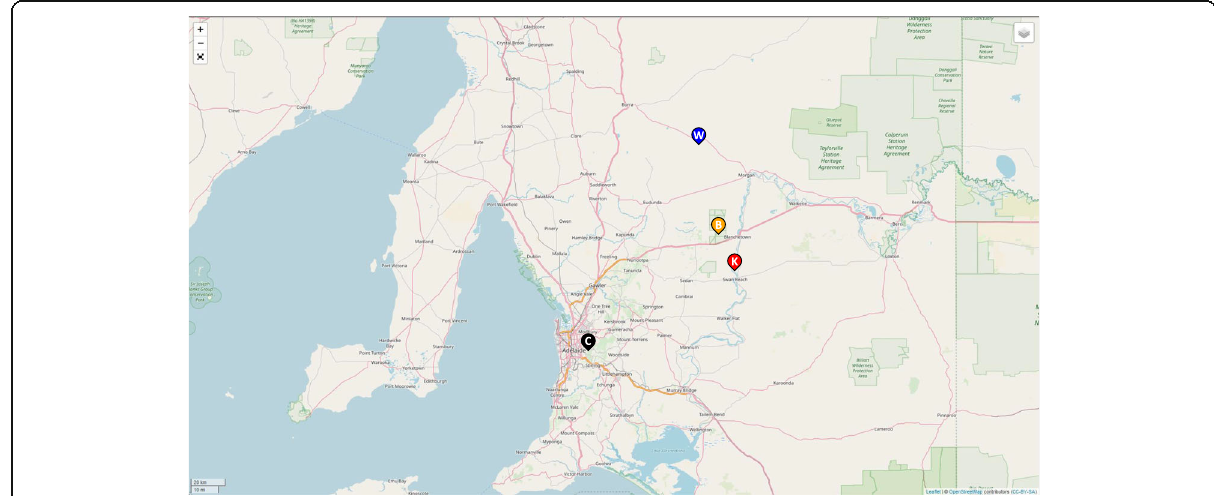
Fig. 1 Map of study sites in South Australia. C = captive population ( n = 21), K = Kooloola Station, degraded habitat ( n = 21), B = Brookfield Conservation Park, degraded habitat ( n = 17), and W = Wonga Station, intact habitat ( n =